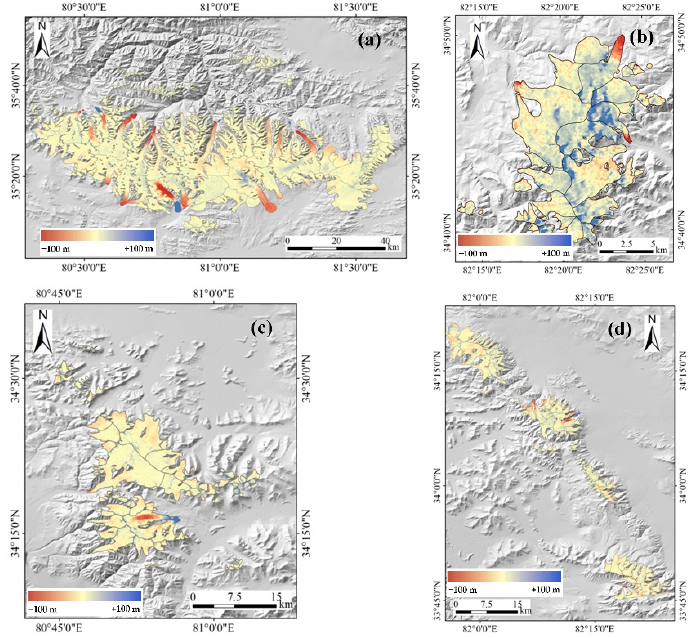
Figure 4. Same as Figure 3 but for the study sites of Gangdisi Mts. ( a ), Zangsigangri Mount ( b ), Unnamed-4 Mts. ( c ) and Unnamed-5 Mts. ( d ).